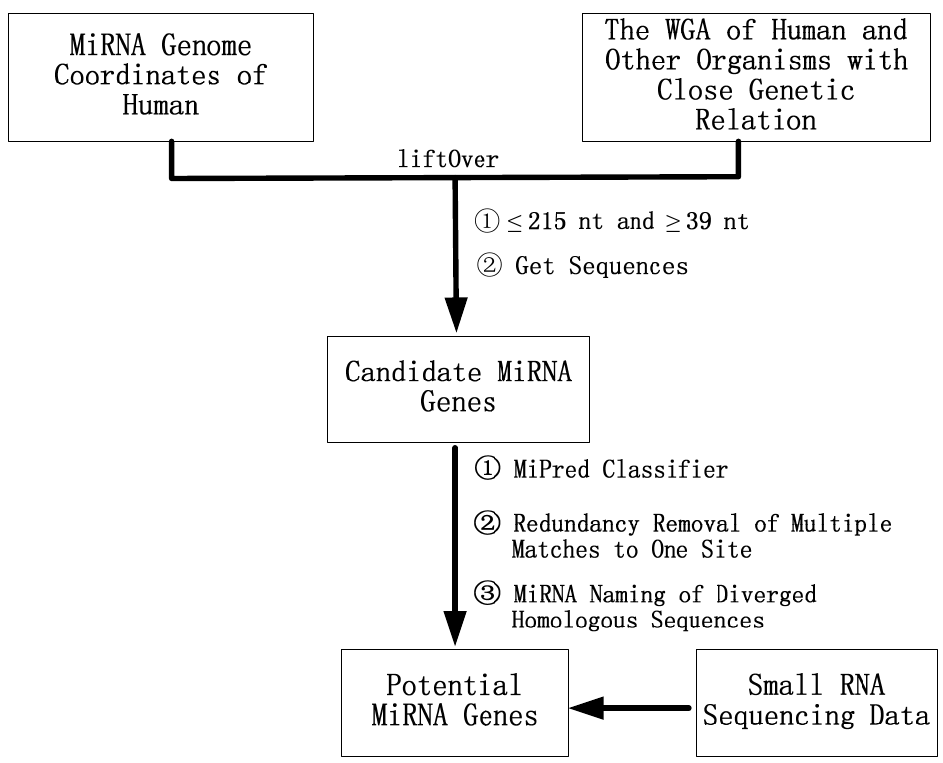
Figure 2. The flow chart used to identify novel miRNAs by using a comparative genomics approach and small RNA sequencing data. WGA: whole genome